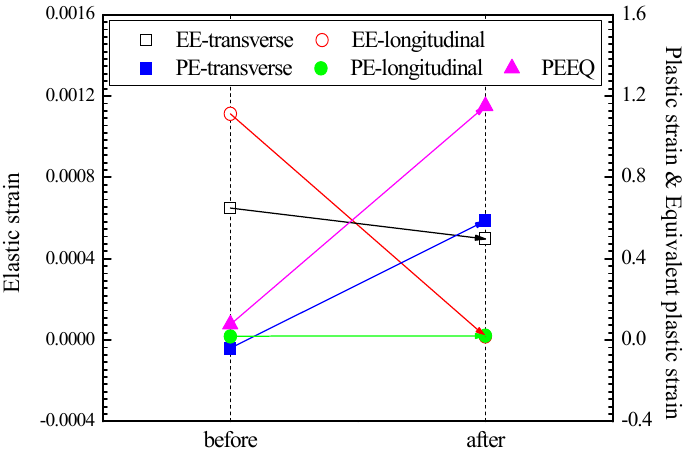
Figure 12. Variation of elastic strain, plastic strain and equivalent plastic strain before and after UIT.